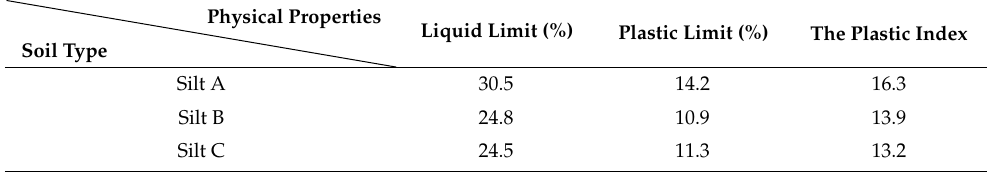
Figure 2. Grading curve of soil particles. Table 1. Physical characteristics of soil.